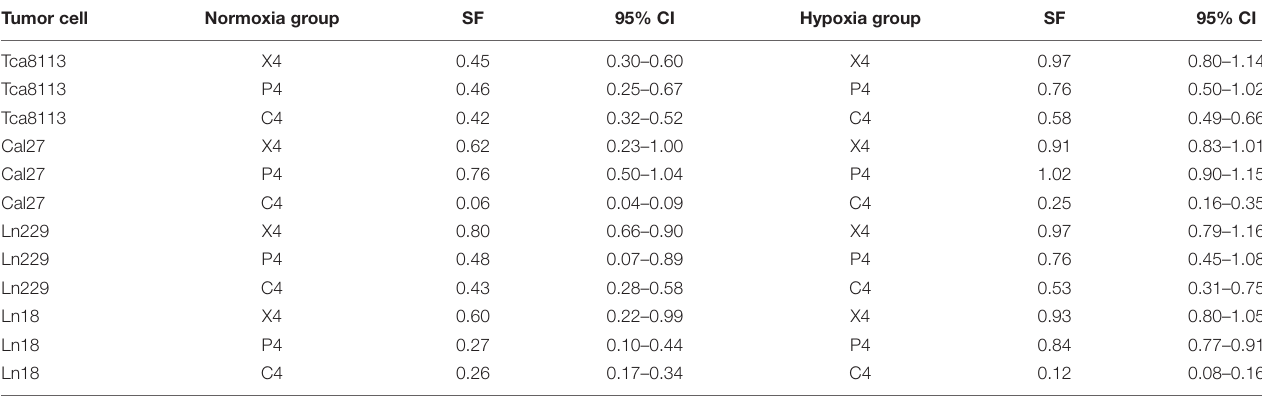
TABLE 1 | The survival fraction of tumor cells following irradiation under normoxia and hypoxia. Tumor cell